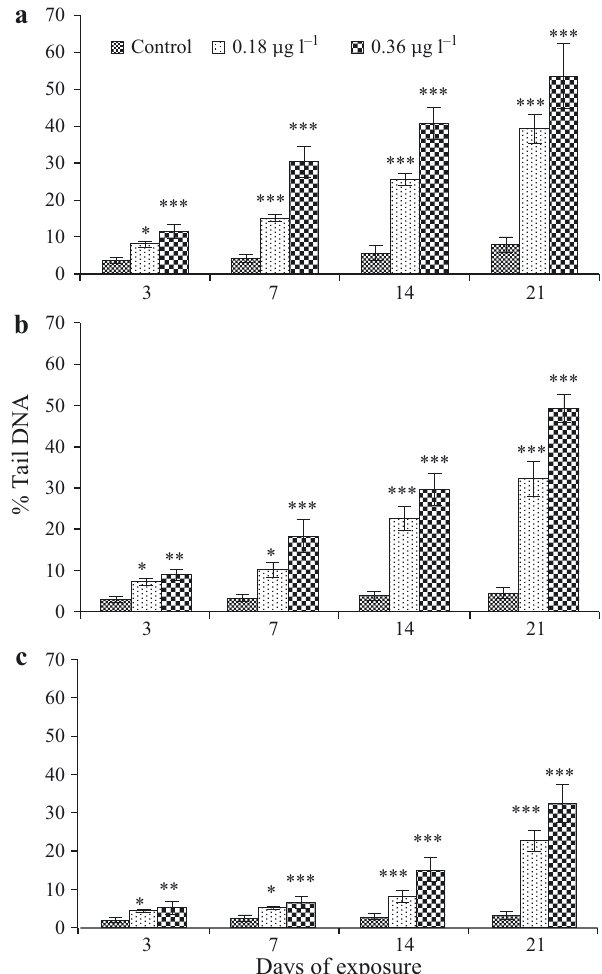
Fig. 2. Percent tail DNA in different cells of Litopenaeus vannamei juveniles exposed to 2 sublethal concentrations (SL1 = 0.36 µg l –1 , SL2 = 0.18 µg l –1 ) of chlorpyrifos at the end of 3, 7, 14 and 21 d of exposure in (a) gill cells, (b) haemolymph and (c) muscle cells. Data are mean ± SD (n = 100 comets). *p < 0.05, **p < 0.01, ***p <